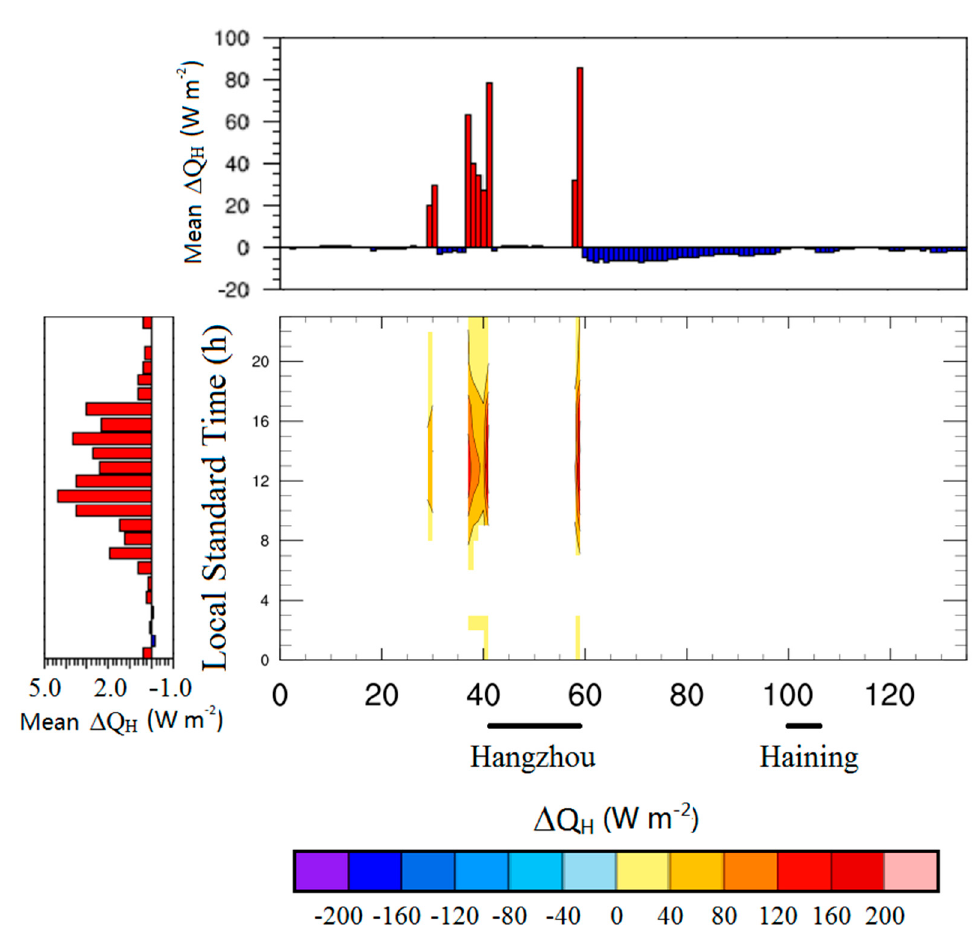
Figure 10. The same as Figure 9, but with surface turbulent sensible heat flux (W m − 2 ). The values between -5 W m − 2 to 5 W m − 2 are masked.